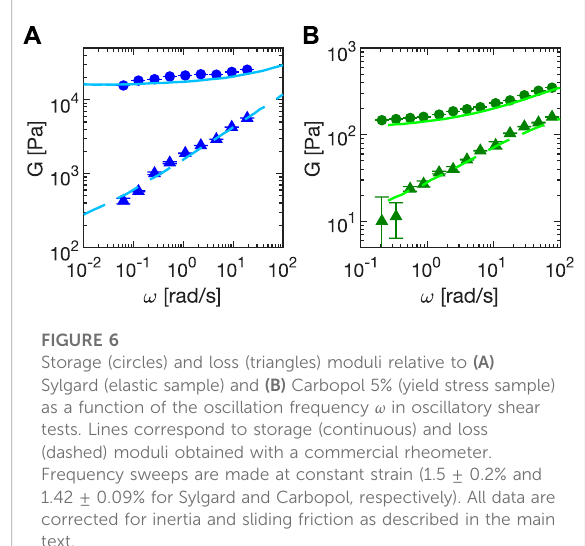
FIGURE 5 Amplitude G of the complex modulus G p as obtained from frequency sweep measurement on glycerol (orange circles) and silicon oil (red circles). Empty (full) circles are obtained without (with)correctionforinertiaandfriction.Intheinset,wereport the measured phase as a function of ω / ω I without the correction. The lines are linear fi ts representing the expected (Newtonian) behavior.